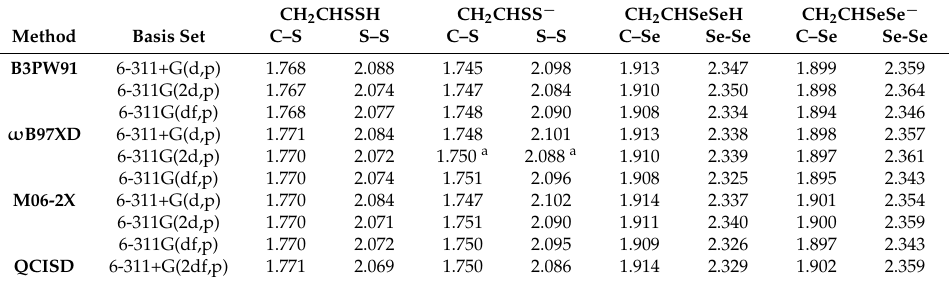
Table 2. Selected optimized bond lengths (in ångstroms; Å) for CH 2 CHXXH and CH 2 CHXX − (X = S, Se).